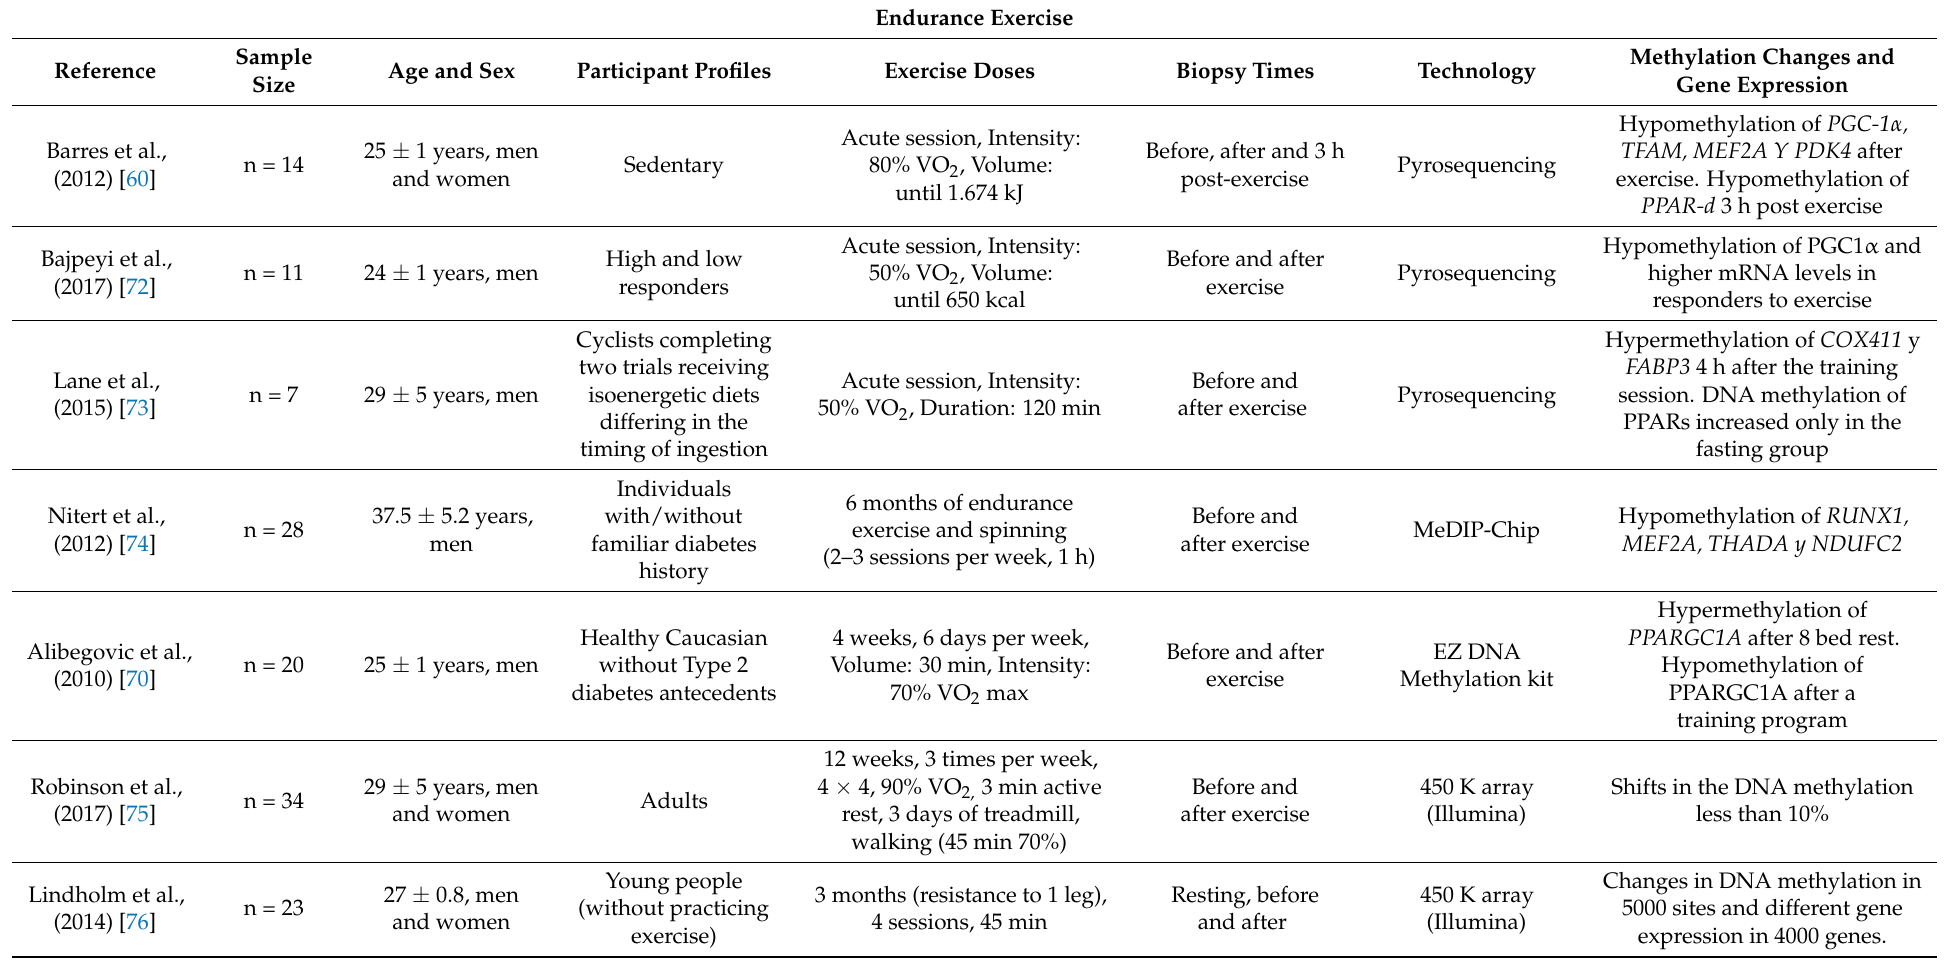
Table 1. Effects of endurance and resistance training on DNA methylation in skeletal